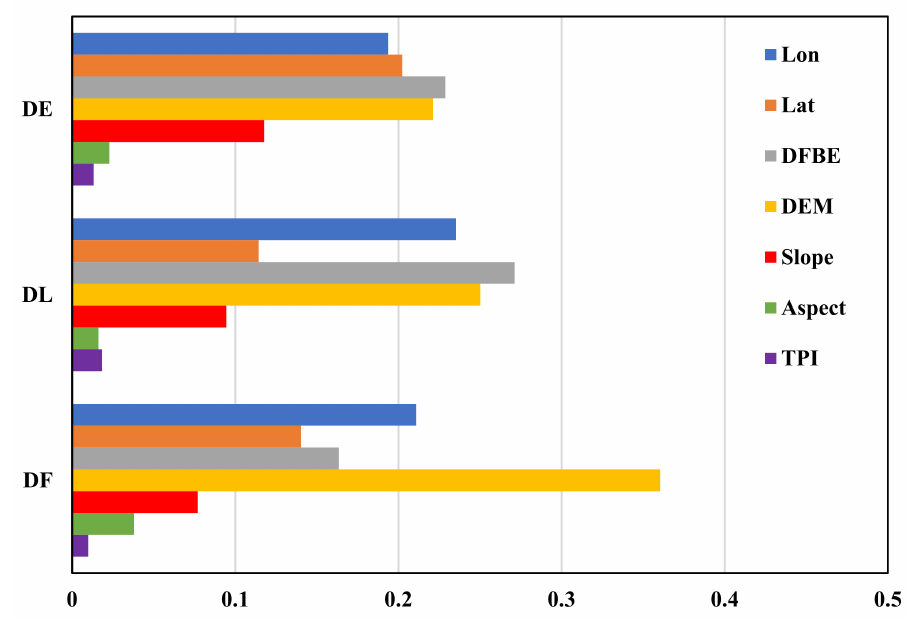
Figure 10. Same as Figure 6 but based on systematic